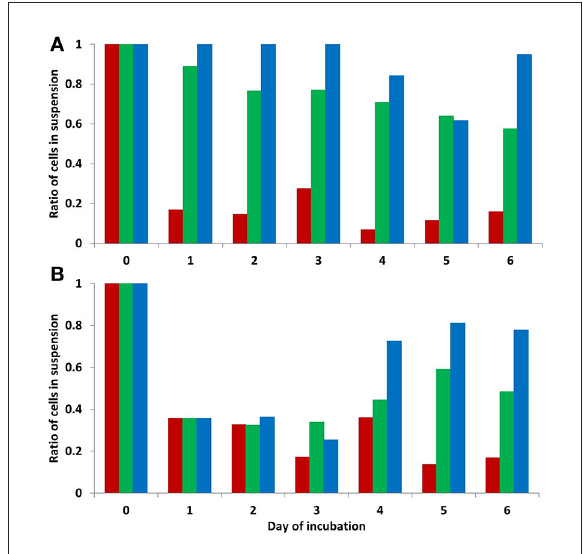
FIGURE2 Ratio of cells in suspension vs. attached cells during 6 days of culturing at different temperatures (8, 17.5, and 37 ◦ C) in Experiment 1 (A) and culturing at different temperatures (8, 17.5, and 37 ◦ C) after preincubation at 37 ◦ C in Experiment 2 (B) . Red column- − 37 ◦ C, green column- − 17.5 ◦ C, blue column- − 8 ◦ C. At temperature 8 ◦ C, the majority of cells were non-adherent in suspension, while attached cells prevailed at 37 ◦ C. Average data shown based on 3 replicates/3 repetitions, n = 9. The proportion of cells in suspension differed significantly between all three cultivation temperatures on day 6 of both experiments (difference test between proportions; p < 0.001).